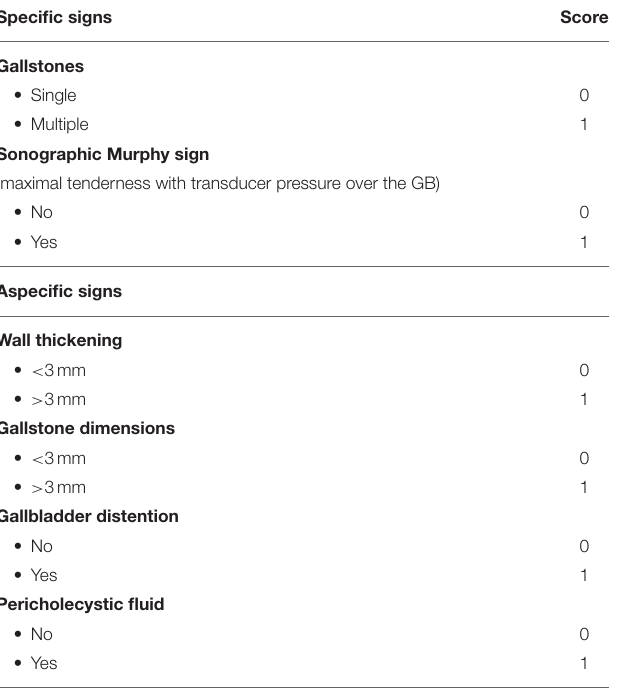
TABLE 1 | Sonographic signs of cholecystitis and score.